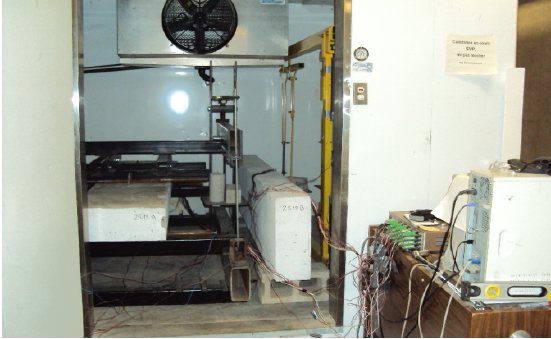
Figure 1. Environmental room including the four point flexural setup, slabs SA and